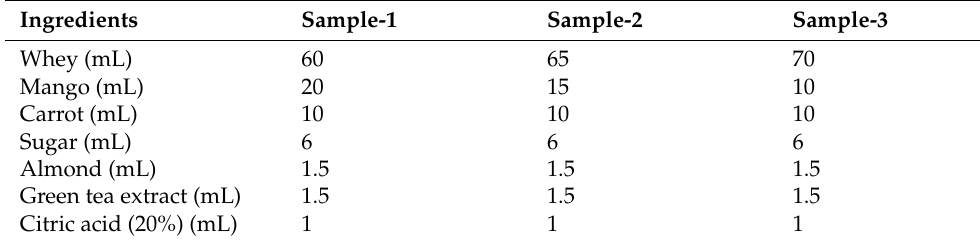
Table 1. Formulation of whey-mango based mixed